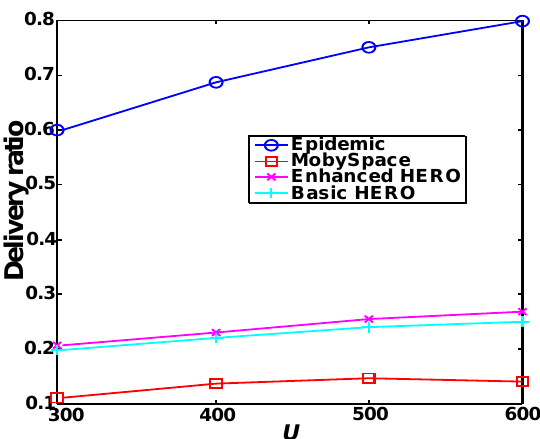
Figure 10. Comparison of delivery ratio. With the help of home, the delivery ratios of two HEROs are much better than that of the MobySpace.